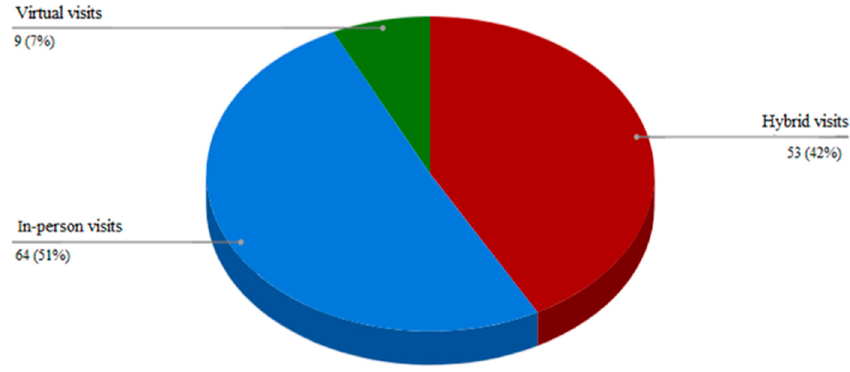
Figure 1. Preferred visit mode.